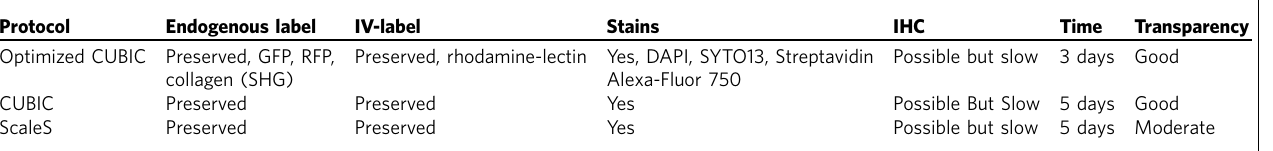
Table 1 | Effect of clearing protocol on affinity ligands. Protocol Endogenous